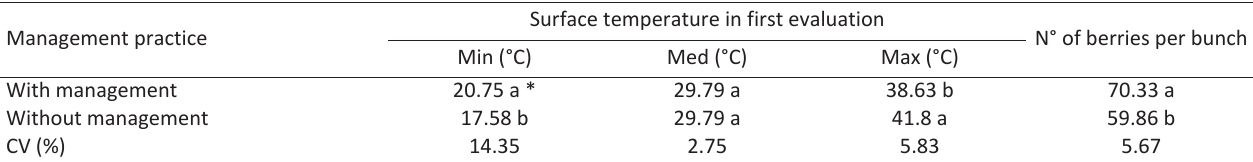
* Means followed by the same lowercase letter in the column do not differ significantly at 5% level of significance by Tukey’s